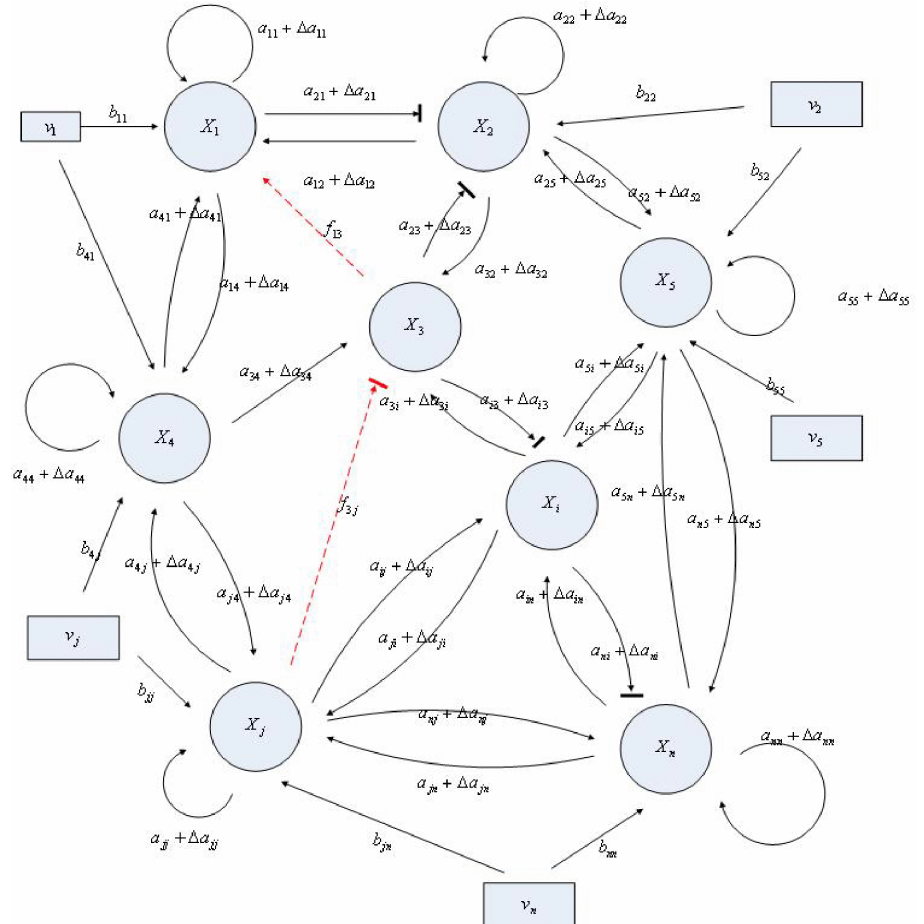
Figure 13. Linear metabolic network of n molecules with intrinsic parameter fluctuation Δ a and extrinsic noise ν network robustness stability and noise-filtering